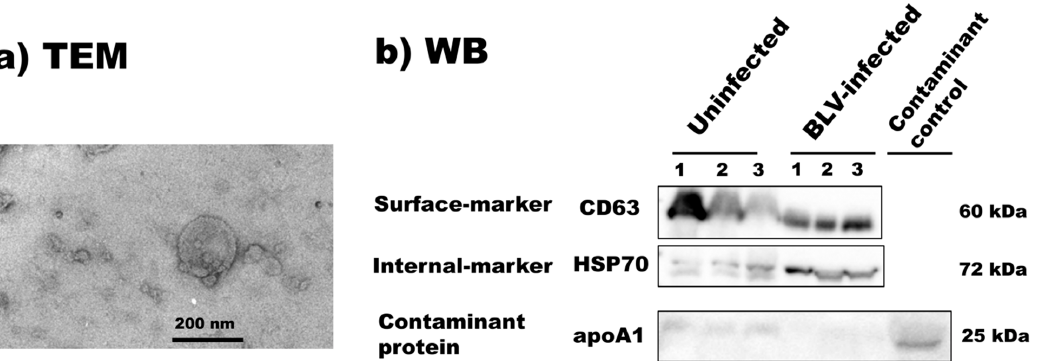
Figure 1. Characterization of bovine milk small extracellular vesicles. Morphology of bovine milk sEVs by transmission electron microscopy analysis ( a ) and detection marker proteins in bovine milk sEVs by Western blot analysis. ( b ) TEM detected bilayer spherical shape sEVs in milk (scale bar shows 200 nm). WB analysis successfully detected surface-marker-protein CD63 and internal- marker-protein HSP70 by using anti-CD63 and –HSP70 antibodies. WB analysis also detected less contaminant protein apoA1 in bovine milk sEVs. TEM, transmission electron microscopy; WB, Western blot. Table 2. Primer information of internal control miRNA candidates in bovine milk sEVs.